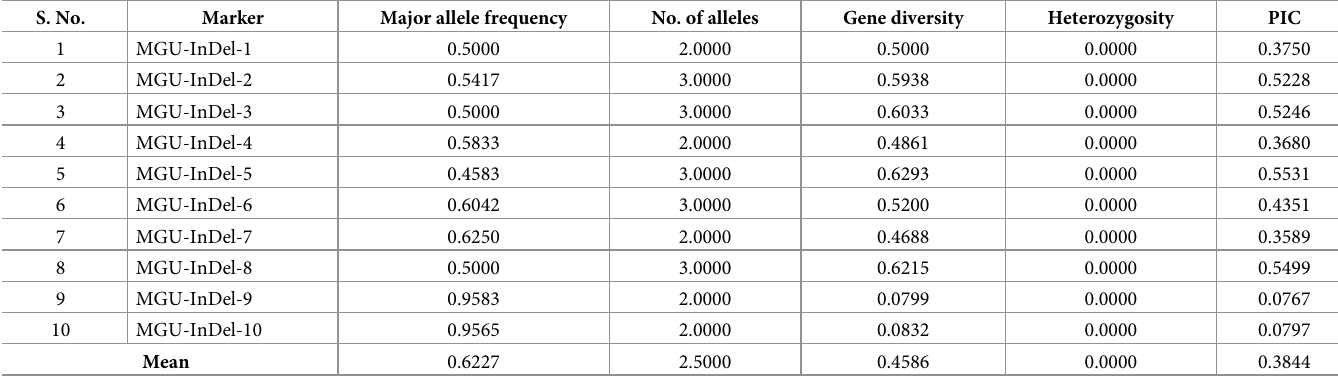
Table 2. Summary statistics of genotyping assay of 48 inbred